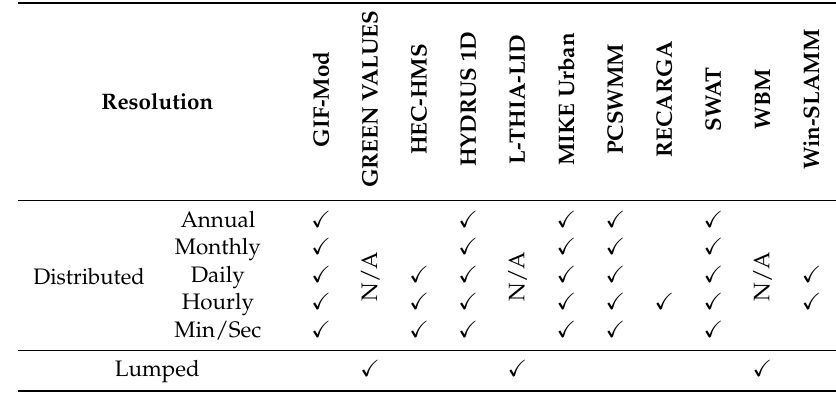
Table 5. Comparing the temporal resolution of the selected